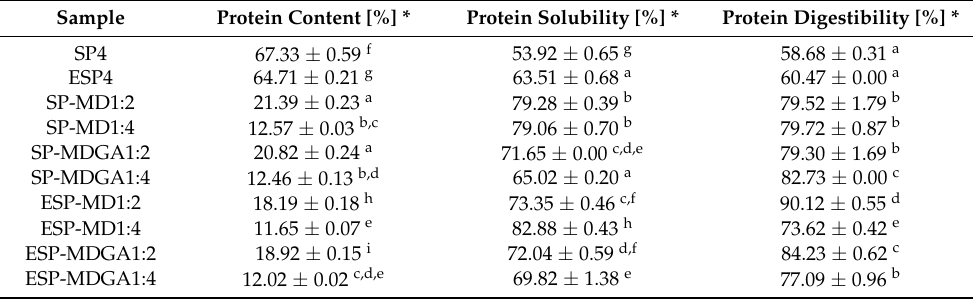
Table 4. Bioavailability, protein content, and solubility of powder